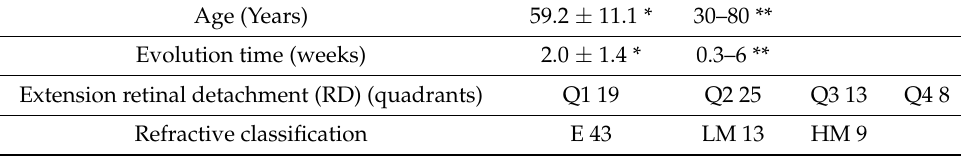
Table 1. The main features of the 65 patients (41 men and 24 women) included in this study.